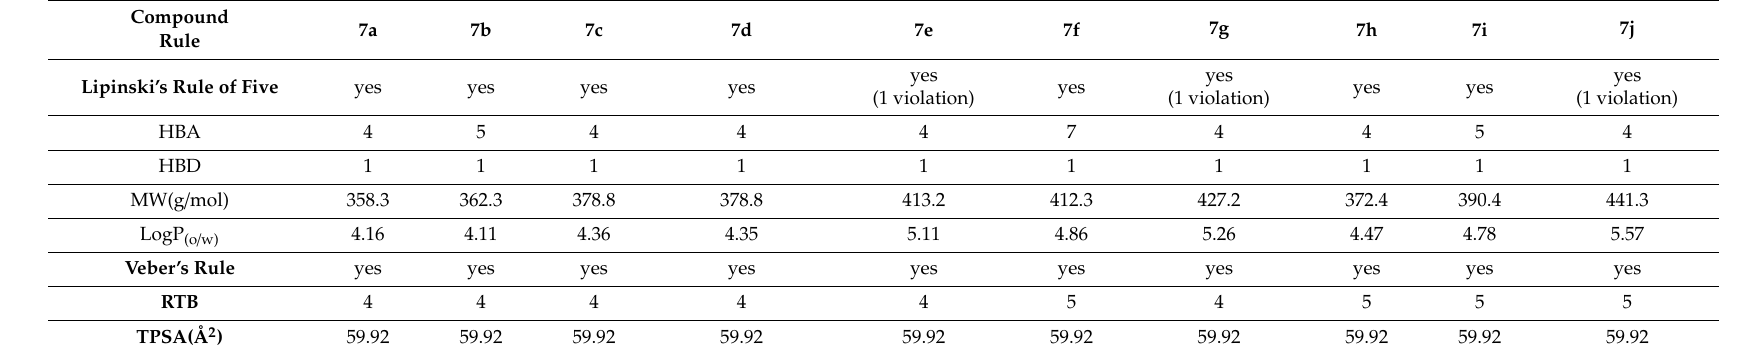
Table 1. Lipinski and Veber’s rules for compounds 7a – j .